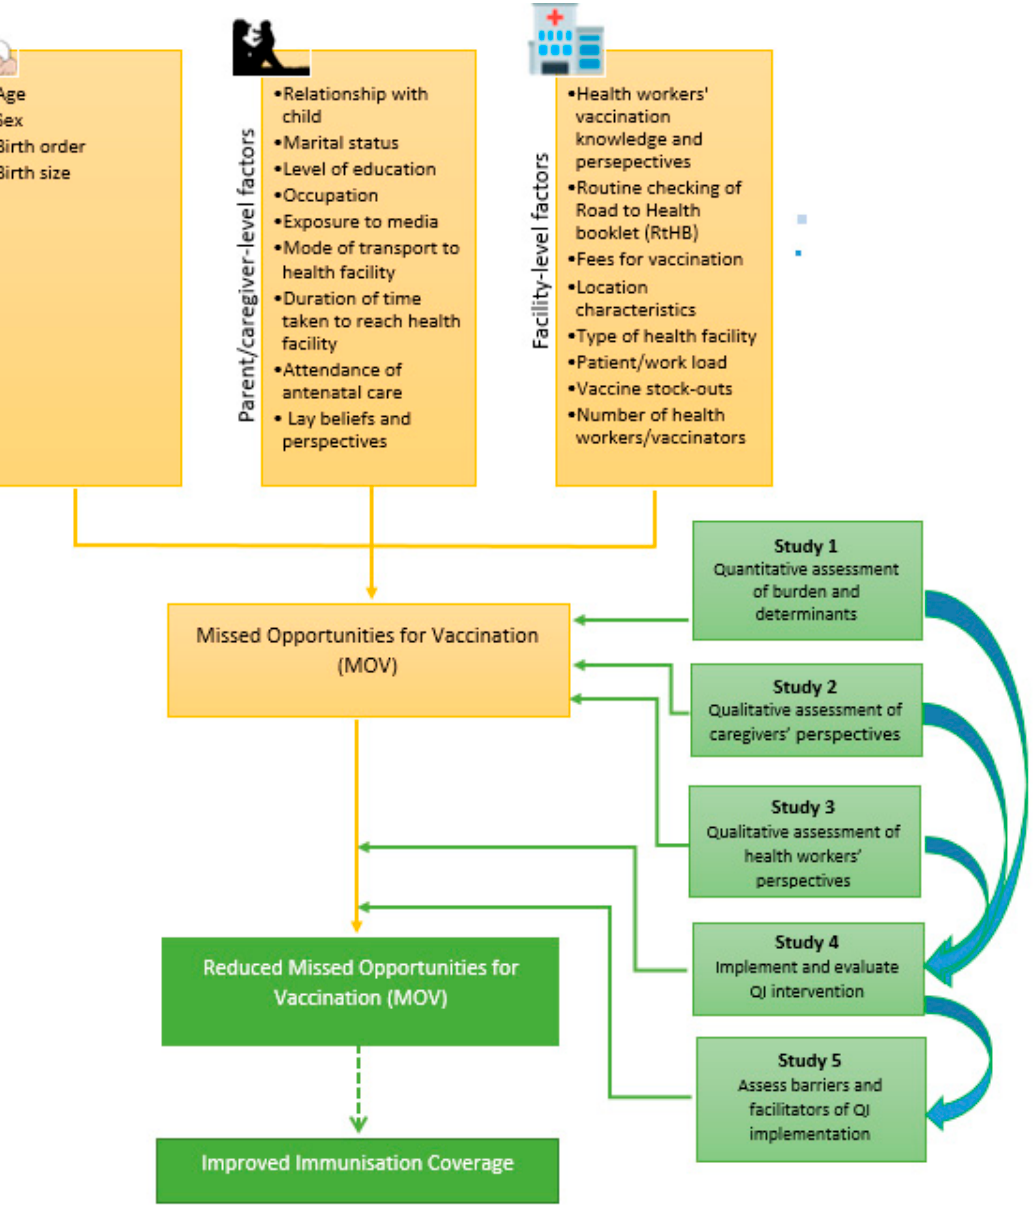
Figure 1. An implementation research work plan for MOV assessment and remediation.